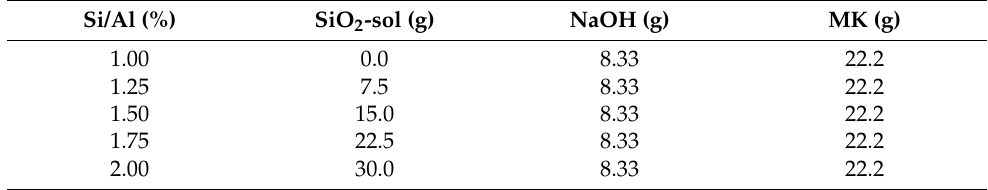
Table 2. Mixture formulations for geopolymer gels with various designated Si/Al molar ratios. Si/Al (%) SiO 2 -sol (g) NaOH (g) MK (g) 1.00